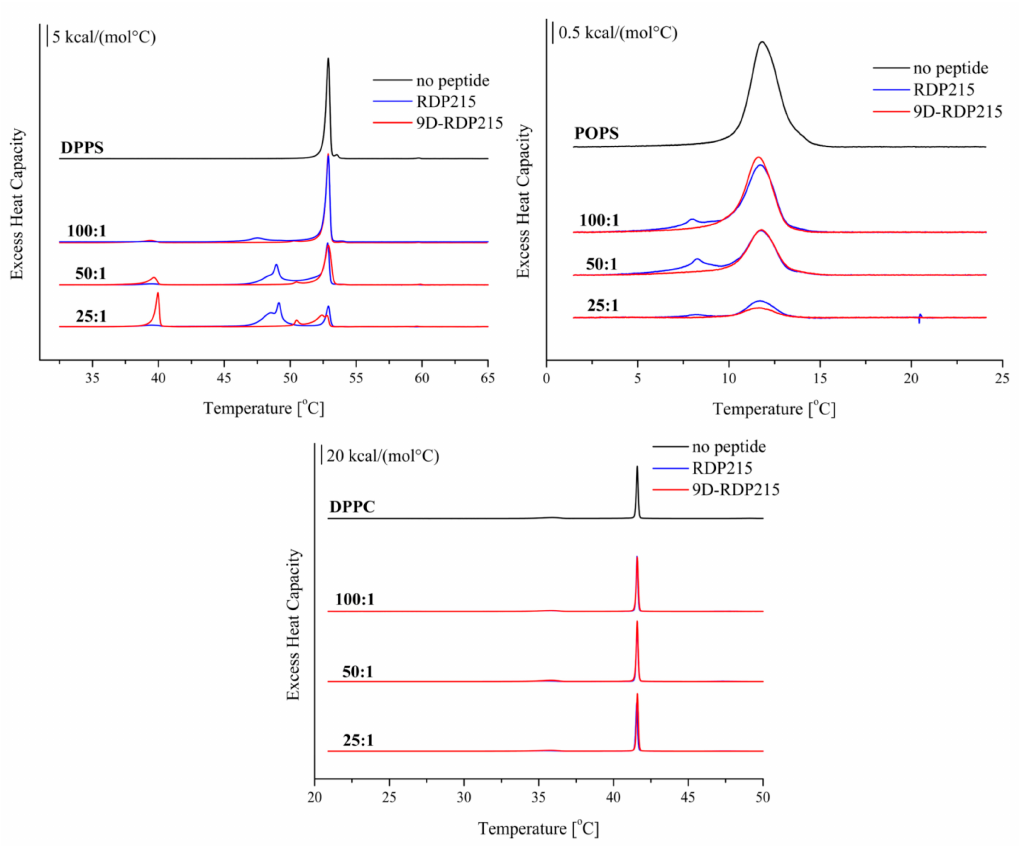
Figure 5. Thermotropic phase behavior of liposomes composed of DPPS, POPS and DPPC in the absence and presence of RDP215 and 9D-RDP215. Liposomes of DPPS (top; left) and POPS (top; right) were used to determine the effect of the two peptides on the cancer marker PS (lipid to peptide molar ratios 100:1, 50:1 and 25:1). The effect on liposomes of the non-cancer mimic DPPC is shown at the bottom. The thermograms in black represent the thermotropic phase behavior of pure lipid in the absence of peptides, blue in the presence of RDP215 and red in the presence of 9D-RDP215. Data are representative for three independent measurements. A repeat of three heating and cooling scans was performed. The third heating scan was used for graphic representation. For clarity, the DSC curves were displayed on the ordinate by an arbitrary increment. Both peptides exhibit a severe change in the thermotropic phase behavior of the cancer mimics DPPS and POPS, indicating strong membrane destabilization. No effect on the non-cancer mimic DPPC is observed.